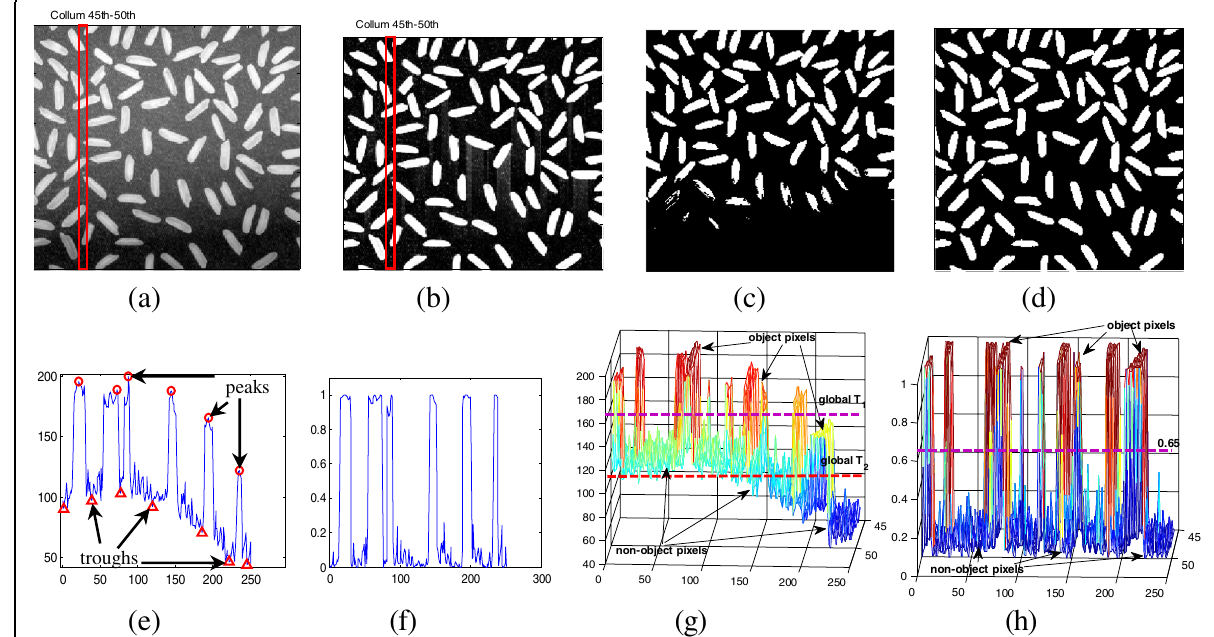
Fig. 6 a The rice image. d The wave transformation image. c – d Segmented images before and after wave transformation using the IFS entropy- based method. e The original wave curve of the 45th column. f The wave transformation result of the 45th column by the fuzzy membership function. g The grayscale wave of the 45th – 50th columns. h The wave transformation result of the 45th – 50th